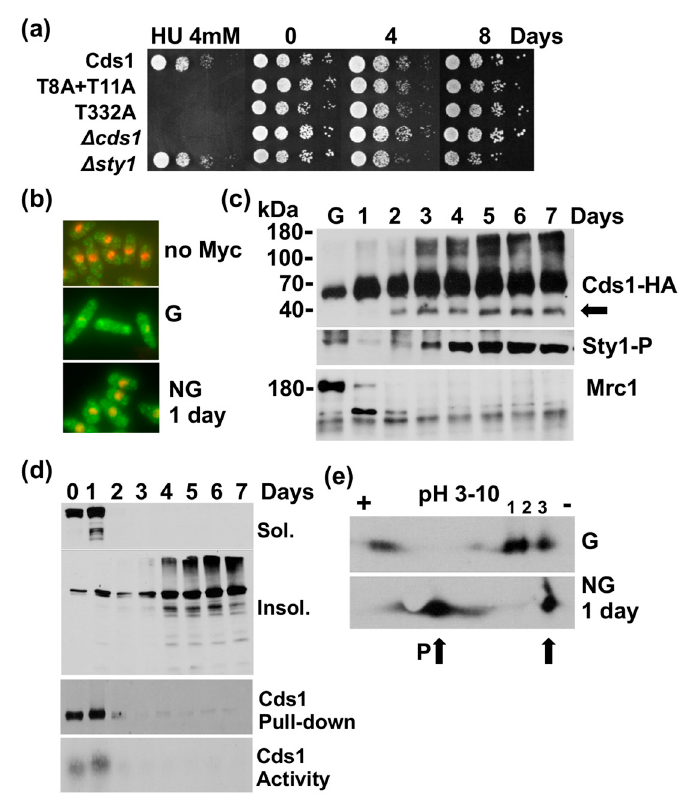
Figure 3. Cds1 undergoes a transformation in the stationary phase. ( a ) Survival of the indicated strains in 3% glucose medium. Samples were harvested on the indicated days in culture (stationary phase). Cell survival on 3% glucose in the presence of 4 mM hydroxyurea (HU) to verify the cds1 strains. T8 and T11 are phosphorylated by Rad3; T332 is in the activation loop of the kinase domain of Cds1. ( b ) Indirect immunofluorescence images of Cds1-Myc 13 in growing cells (G) and after 1 day in culture (stationary phase, NG) (overlay of red = DAPI and green = antibody signal). ( c ) Total protein extracts harvested at the indicated days in a 3% glucose culture (G = growing cells, arrow = N-terminally truncated Cds1 form, Sty1-P = dual T171 + Y173 phosphorylation, Mrc1 = 180 kDa band). Sty1-P and Mrc1 were analysed in the Cds1-HA 2 His 6 extracts. ( d ) Samples were withdrawn on the indicated days in 3% glucose culture (sol. = soluble protein, insol. = Insoluble protein, immunoprecipitated Cds1-HA 2 His 6 and in vitro kinase activity). ( e ) Isoelectric focusing of Cds1-HA 2 His 6 (P = more negatively charged species. Arrows = changes in low glucose medium, G = growing cells, NG = 1 day in culture (stationary phase)).